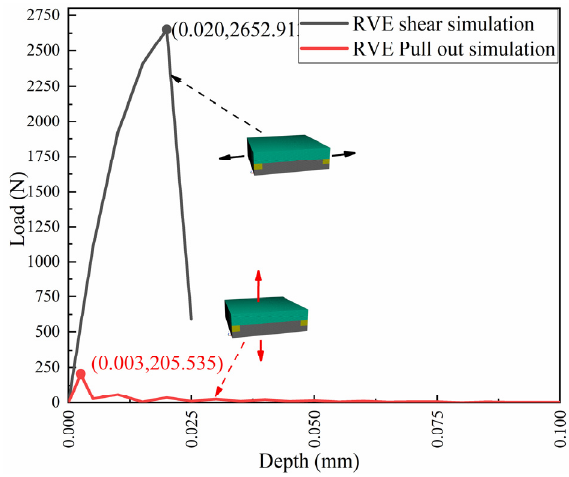
Figure 8. Load–displacement curve of the shear and pull-out tests. Table 1. Initial stiffness of the interface, damage initiation and propagation parameters.